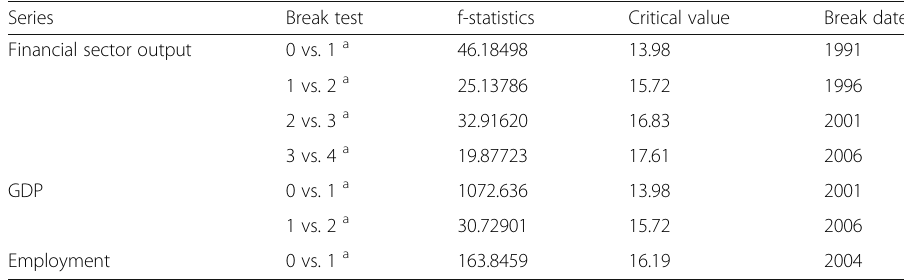
Table 3 Bai and Perron Structural break test Series